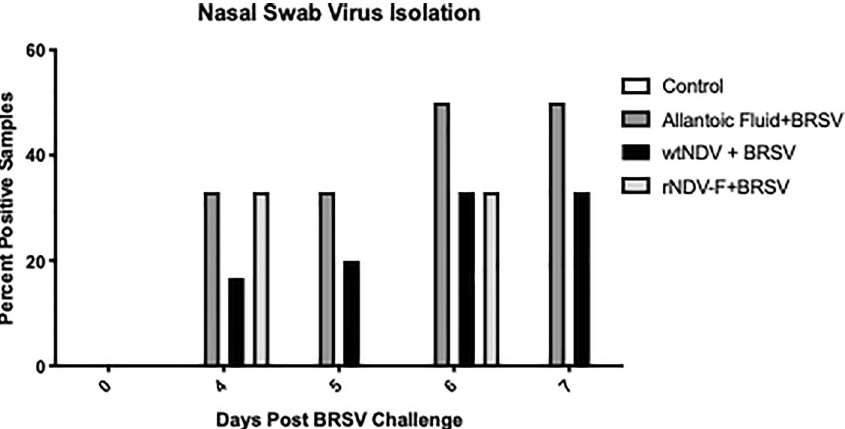
Figure 4. Reduced virus shedding of rNDV-BRSV F opt vaccinated colostrum-deprived calves. Treatment groups of calves included: unvaccinated, uninfected controls (n = 5); intranasal (i.n.) allantoic fluid vaccinated (mock vaccine control) and BRSV challenged (n = 6); i.n. wtNDV-vaccinated and BRSV challenged (n = 6); i.n. rNDV- BRSV F opt vaccinated and BRSV challenged (n = 6). Prior to vaccination, weekly following vaccination, and each day after experimental challenge, nasal swab samples were collected and placed in MEM containing antibiotics/ antimycotics. Samples were vortexed and clarified by centrifugation and supernatants used to inoculate BT cells for virus isolation. Daily observations for cytopathic effect were conducted and recorded for 7 days following inoculation of cells. Results shown are the percentages of calves in each group which were positive for virus